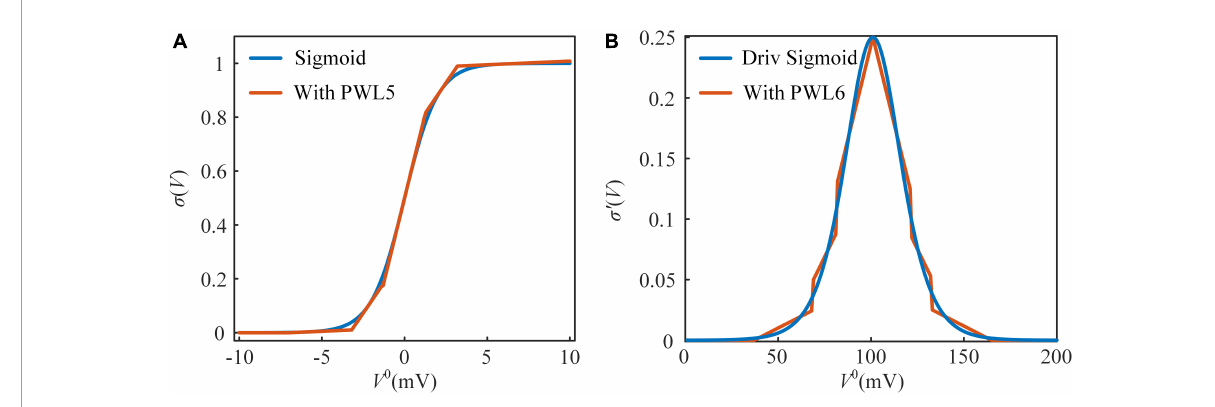
FIGURE2 The approximated sigmoid functions and their derivative functions. (A) The sigmoid function and its approximated function with piecewise linear 5 (PWL5). (B) The derivative of the sigmoid function and its approximated function with piecewise linear 6 (PWL6).